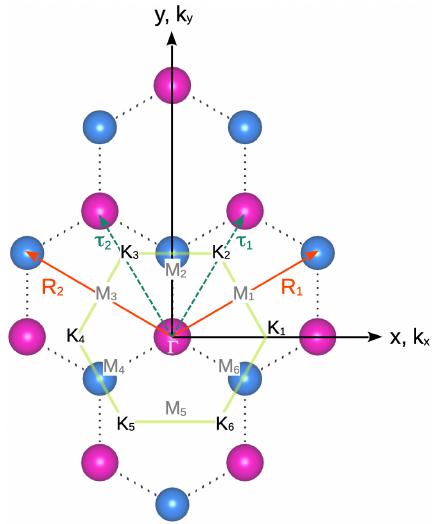
Figure 7. Atomic arrangement of boron (magenta) and nitrogen (blue) atoms in a monolayer of six- ring boron nitride in the ( 001 ) plane. The vectors of the direct lattice ( τ 1 and τ 2 ) are plotted in dark green and the vectors of the reciprocal lattice ( R 1 and R 2 ) are plotted in red. The edges of the Brillouin zone are shown as light green lines. The black lines represent the orientations of the vectors x and y of the international basis set representation for the direct lattice and for their analogs k x and k y . Note the positions of the specific points of the reciprocal lattice Γ , K i , and M i